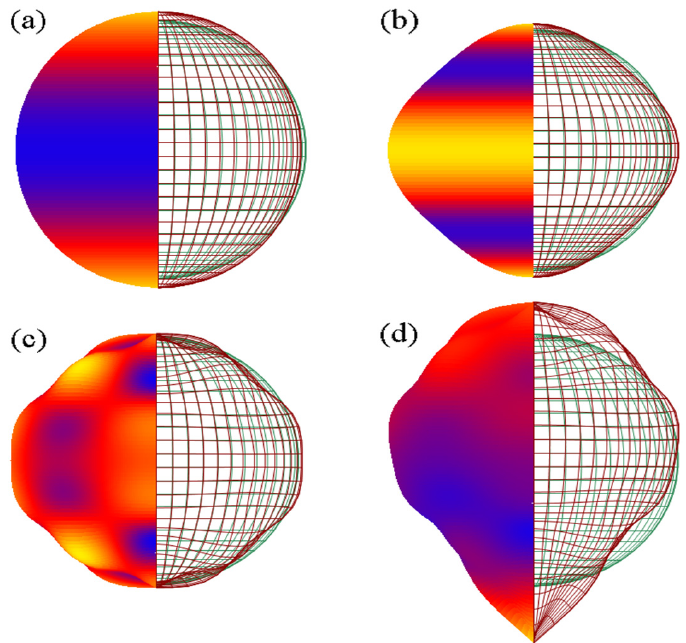
(cid:3104) 𝑙 (cid:3440) . (cid:2870) (cid:3030) (cid:3118)(cid:3280)(cid:3281)(cid:3281)